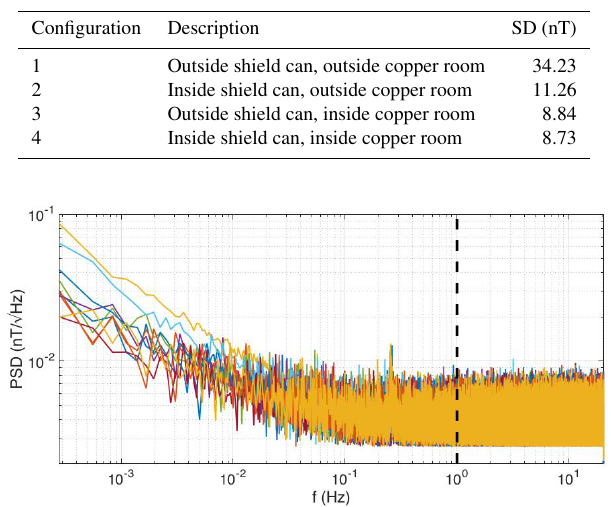
Figure 6. Power spectral density of 10 different signals with dura- tion of 1h with an external DC field. The level of the noise density at 1Hz (vertical dashed line) is taken as a measure of the noise floor of the instrument.